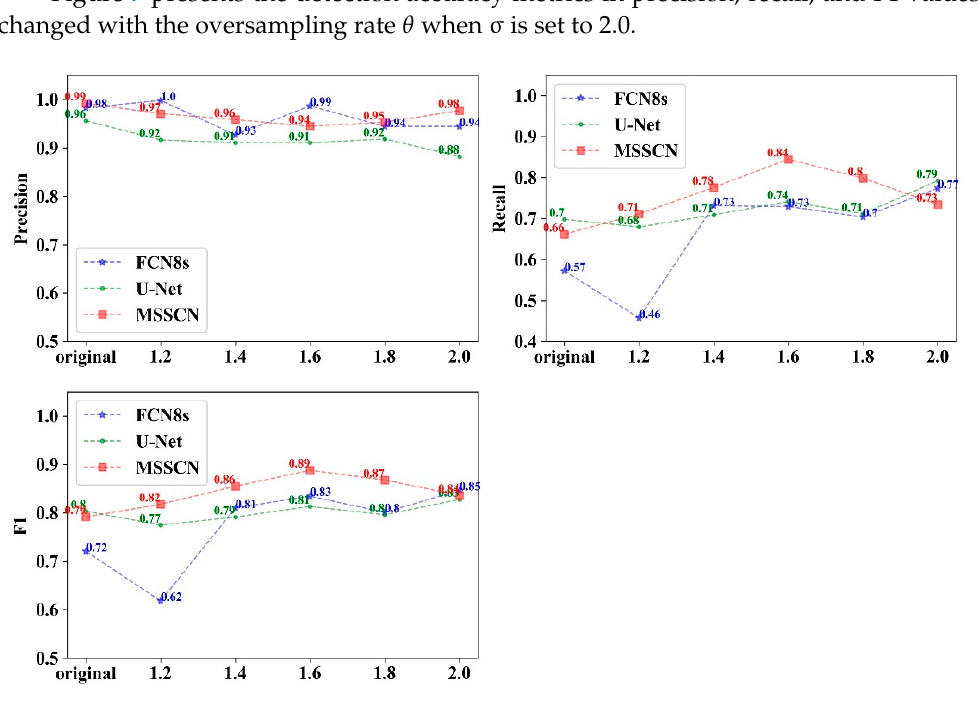
Figure 7. The comparison of the proposed approach with benchmark approaches in all sites changed with 𝜃 when 𝜎 was set to 2.